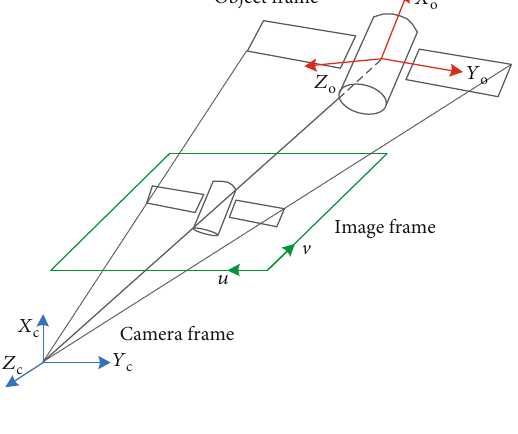
Figure 2: Reference